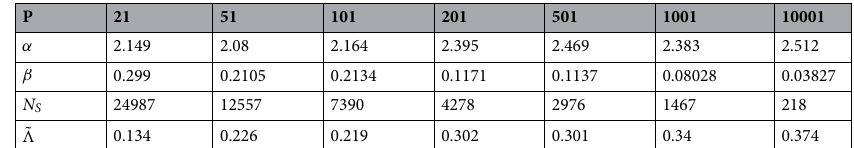
Table 1. Parameters of least-squares fitting, according to Eq. (3), for the data of all simulated population sizes. Also included in table is the saturation step N S , and the knee point location